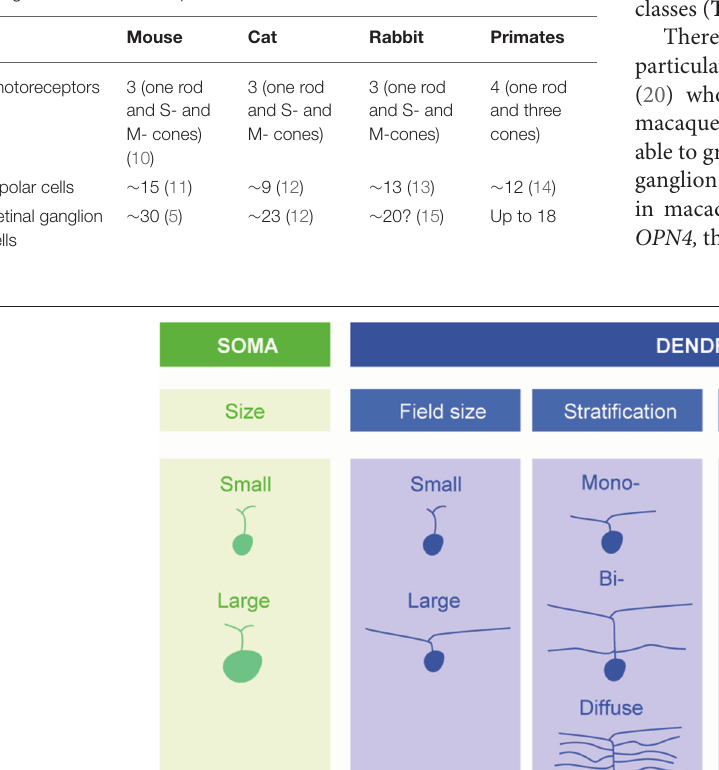
Frontiers in Neurology |